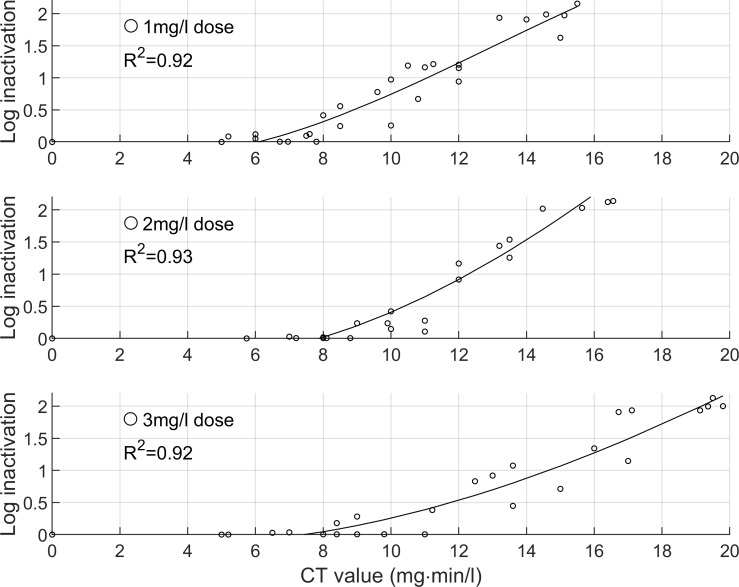
Log inactivation of S. mansoni cercariae versus CT values, for chlorine dose of 1, 2, 3 mg/l.Data shown is for pH 6.5 and 20°C.